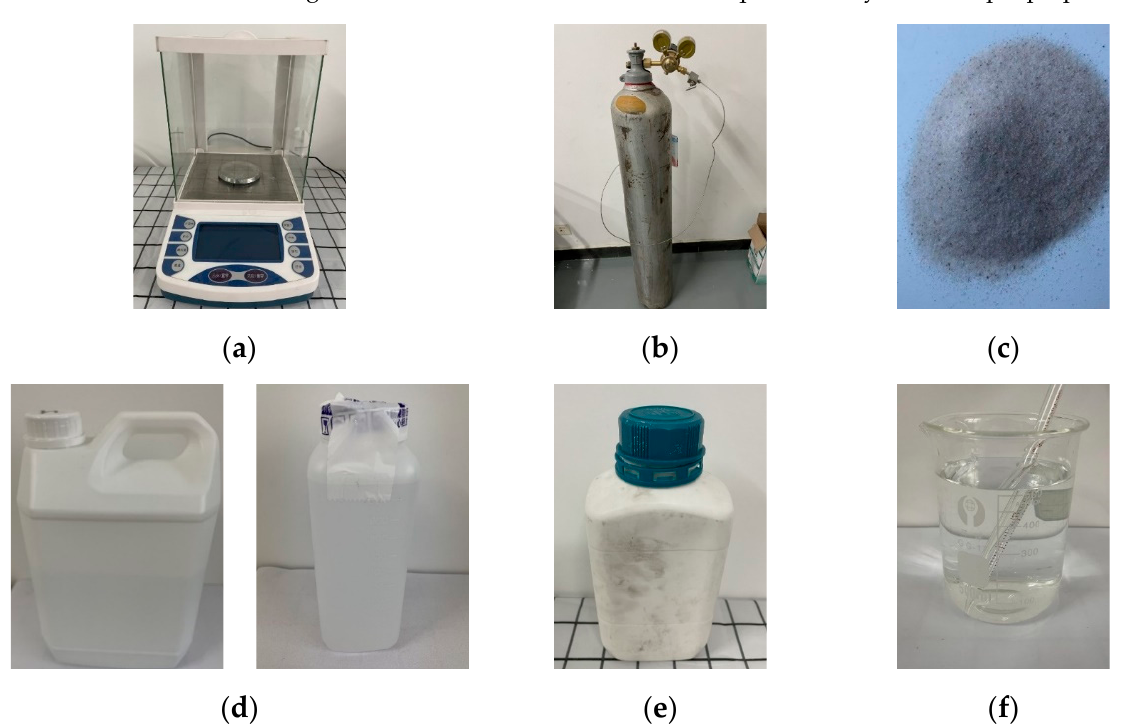
Figure 2. Tools and materials for samples preparation. ( a ) Electronic analytical balance. ( b ) Test gas. ( c ) Quar tz sand. ( d ) Epoxy resin. ( e ) SDS. ( f ) Deionized water.